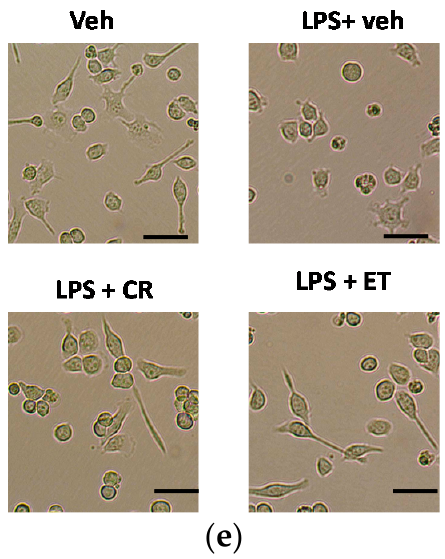
Figure 1. Effects of ethanol extracts of C. rutidosperma (CR) and E. thymifolia (ET) on lipopolysaccharide (LPS)-stimulated nitric oxide (NO) production and activation. BV2 cells were pre-treated for 0.5 h with polymyxin B (PMB, 10 µg/mL), vehicle (0.1% ethanol), or the indicated concentration of extract, and then stimulated with LPS (10 or 100 ng/mL) for 20 h. ( a , b ) The nitrite production in supernatant was determined by the Griess reagent; ( c , d ) The cell viability was analyzed by MTT assay. Data are represented as the mean ± SD ( n = 3). Statistical differences are presented ** p < 0.01 compared with the vehicle control (without LPS) and ## p < 0.01 compared with the LPS-treated vehicle; ( e ) Representative images of BV2 microglia incubated for 20 h with vehicle (0.1% ethanol), LPS (10 ng/mL) plus vehicle (0.1% ethanol), LPS (10 ng/mL) + CR (0.05 mg/mL) or LPS (10 ng/mL) + ET (0.05 mg/mL). Images were acquired with Nikon Eclipse Ti-E inverted microscope (Scale bar, 50 µm).